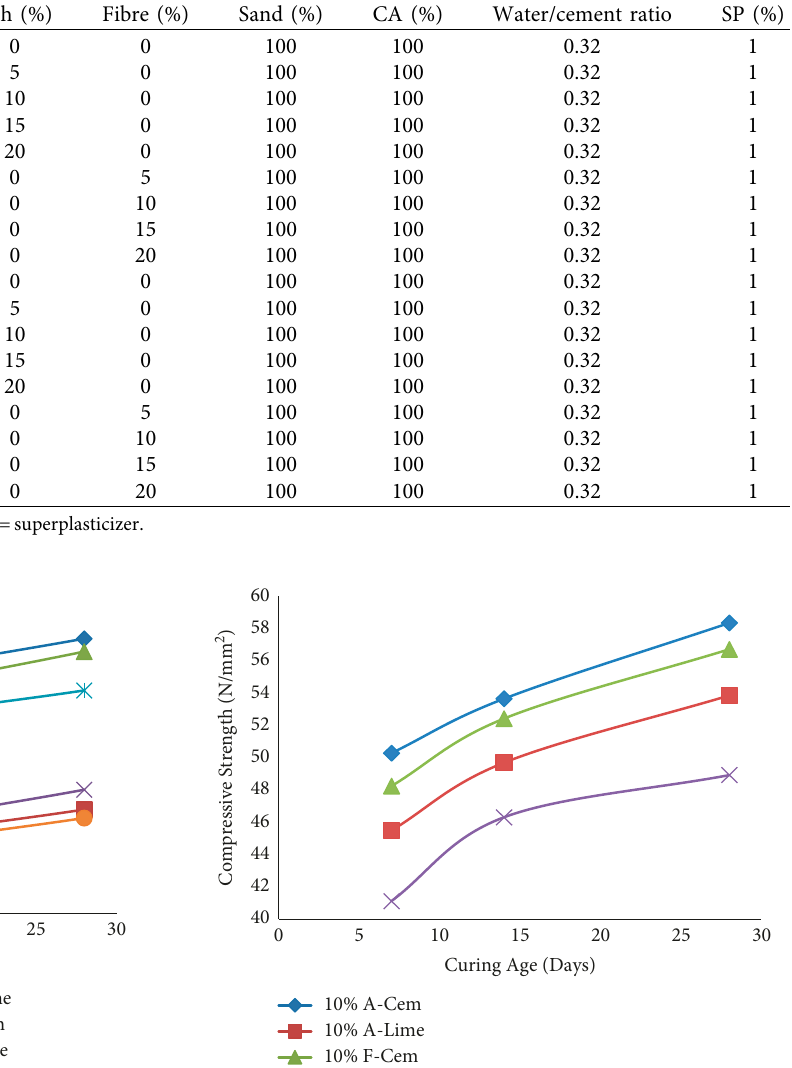
Figure 1: Compressive strength of cement and lime with 5% bagasse ash and fibre. Figure 2: Compressive strength of cement and lime with 10% bagasse ash and fibre.